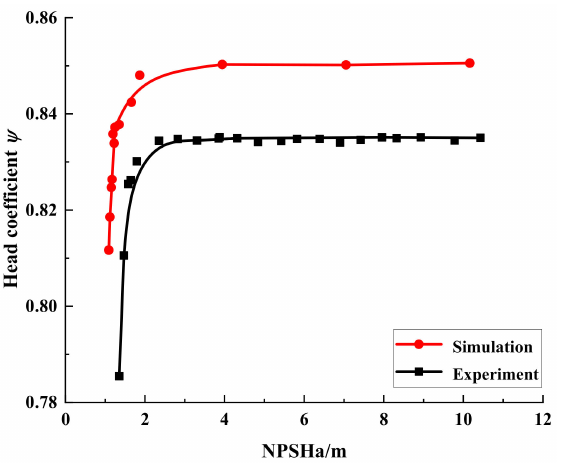
Figure 8. Comparison of cavitation performance curves between numerical and experimental